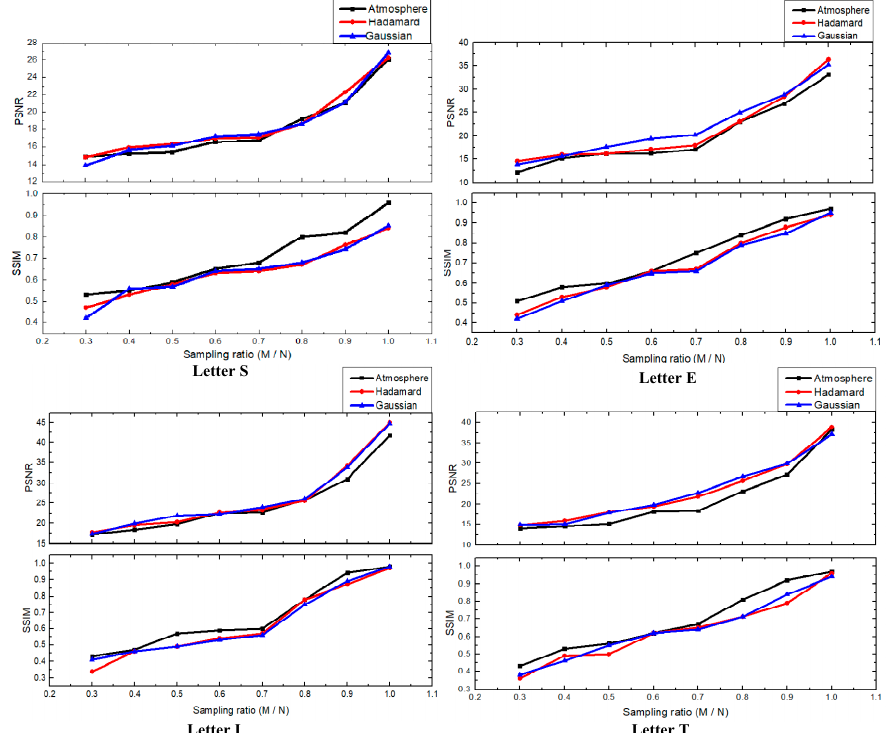
Figure 5. Comparison of image quality reconstructed using three different measurement matrices: simulated atmospheric matrix, Hadamard matrix, and random Gaussian matrix. The reconstructed target images were the letters S, E, I, and T. The sampling rate increased in steps of 0.1 from 0.3 to 1.